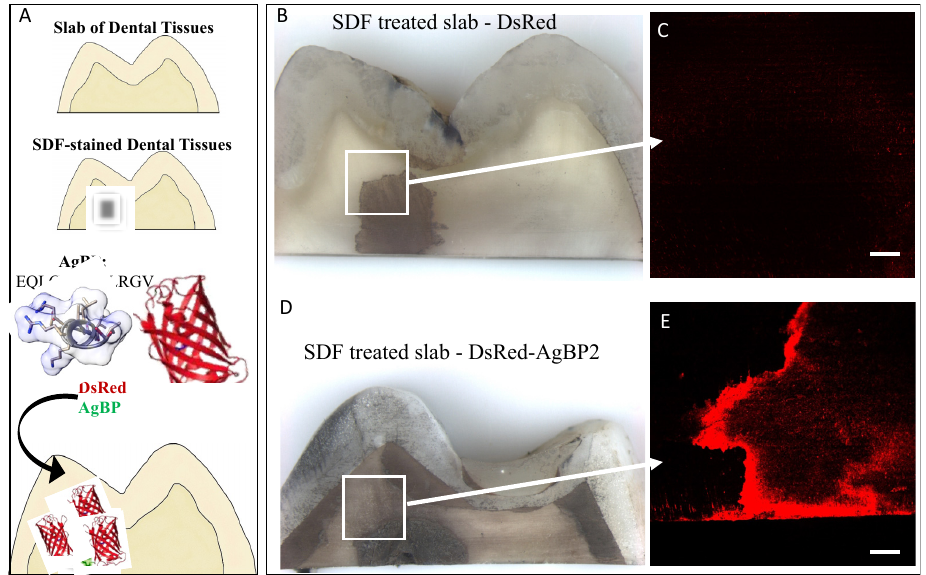
Figure 1. DsRed–AgBP assembled selectively on silver stains on slabs of dental tissues treated with SDF and visualized by fluorescence signal ( A ). Control, DsRed protein alone ( B,C ) or DsRed–AgBP2 ( D,E ) functionalized SDF-treated slabs were surveyed by fluorescence microscopy. Scale bars are 1000 mm for bright field images and 100 μ m for fluorescence images.